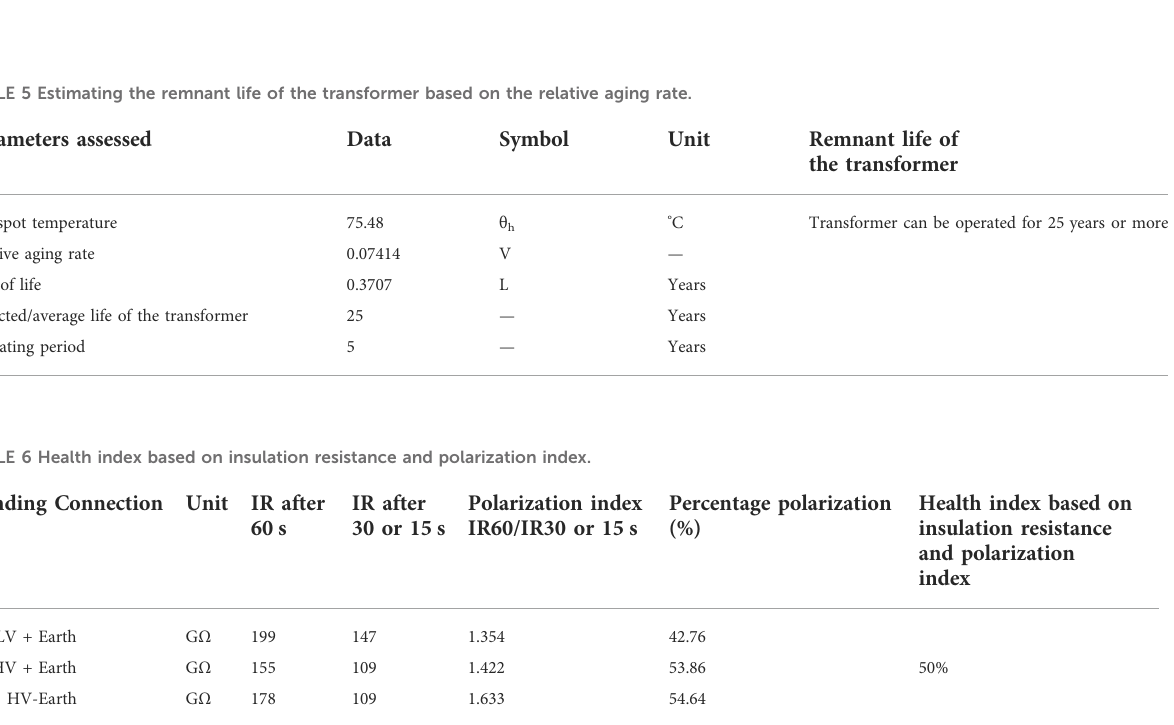
300 ° C < t < 700 ° C. Figure 7B shows that a total of 11 rules are used to develop a fuzzy submodel for Duval triangle 1. The results of DGA showed that no gases of CH 4 , C 2 H 2 , and C 2 H 4 are generated, so their percentage is also zero, and the result from the output of Duval triangle 1 is zero, which means that no fault is detected. Figure 7A shows the surface formed for DGA, which represents, e.g., that when the value of CH 4 is greater than 98%, no matter what is the value of C 2 H 4 , the output will be between 1.00 and 14.29, which means the fault type is PD (partial discharge of corona type) as also shown in Table 3.